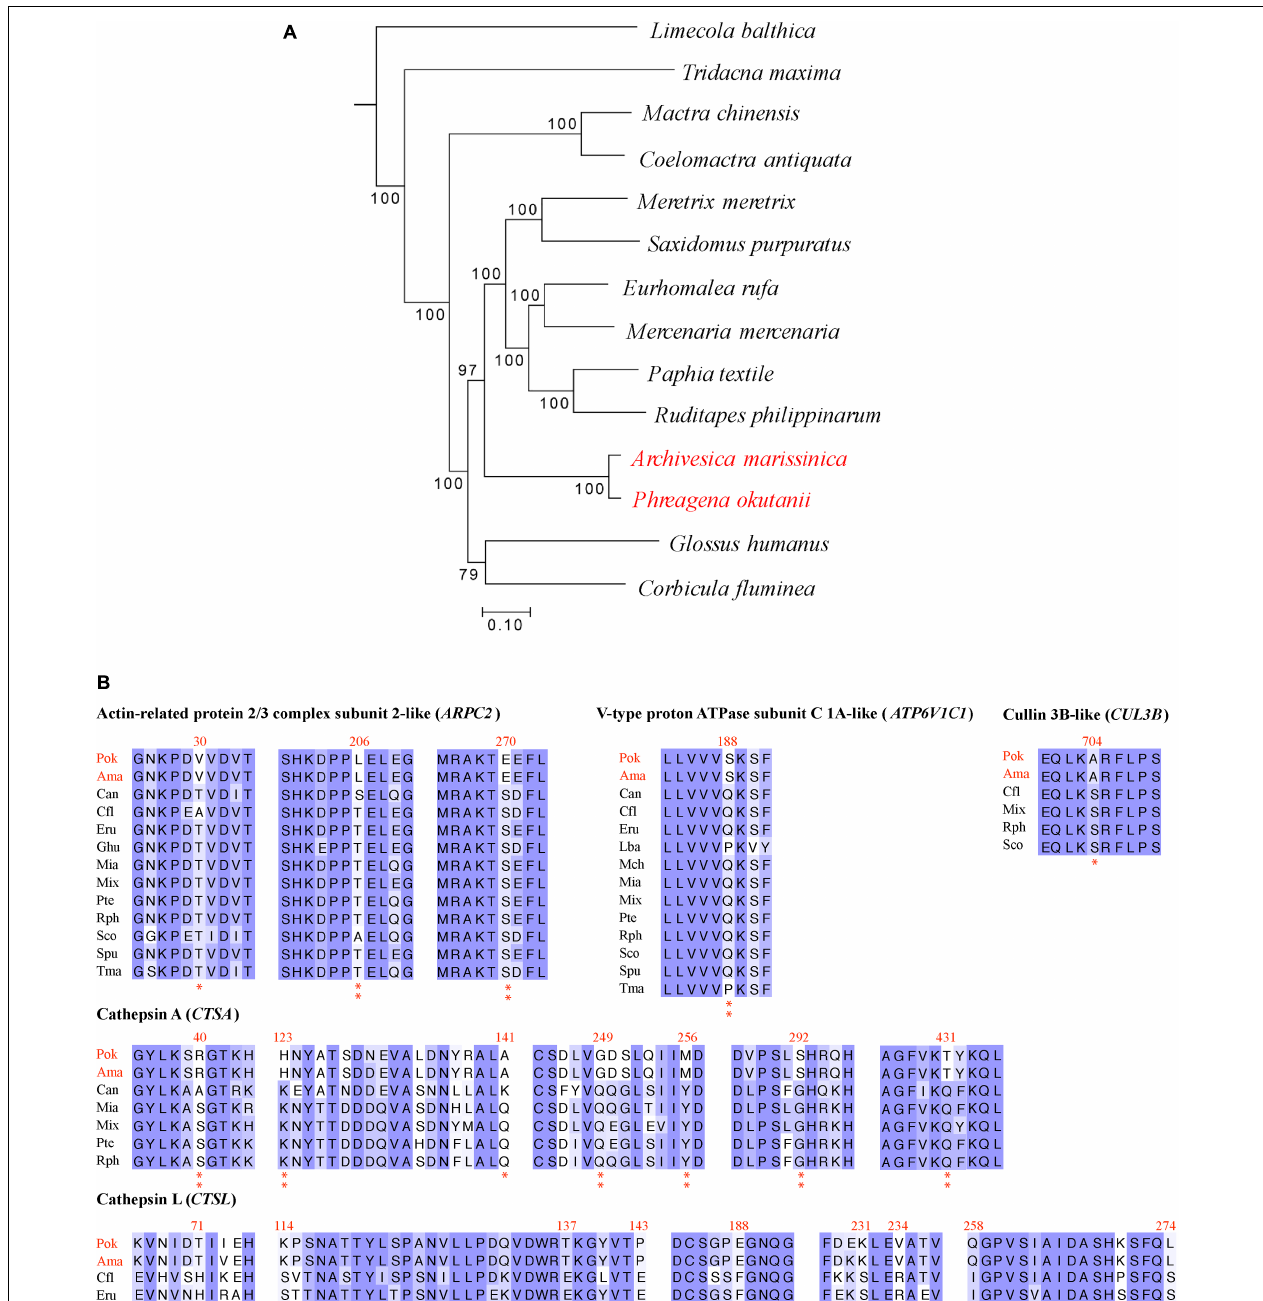
FIGURE 4 | Positively selected genes identified in deep-sea Phreagena and Archivesica . (A) Phylogeny of Veneroida clams with transcriptomes. The number next to the nodes is the bootstrap value from maximum likelihood analysis. A total of 151,496 nt coding DNA sequences contributed to this phylogenetic tree. The outgroup is Sinonovacula constricta in the Solecurtidae family. (B) Partial alignments of the positively selected genes. The shallow-water species with multiple copies of homologs were excluded from the analysis of the given gene. The Arp2/3 complex, cathepsin A, cathepsin L, cullin 3B-like protein, and V-type proton ATPase subunit C 1A-like protein involved in the vesicle trafficking and lysis process have a clear sign of positive selection. Double asterisks denote the amino acids in both Phreagena okutanii and Archivesica marissinica with a BEB posterior probability exceeding 0.95 and a single asterisk indicates the sites with a posterior probability above 0.9 but below 0.95 (Pok: Phreagena okutanii ; Ama: Archivesica marissinica ; Can: Coelomactra antiquata ; Cfl: Corbicula fluminea ; Eru: Eurhomalea rufa ; Ghu: Glossus humanus ; Lba: Limecola balthica ; Mch: Mactra chinensis ; Mia: Mercenaria mercenaria ; Mix: Meretrix meretrix ; Pte: Paphia textile ; Rph: